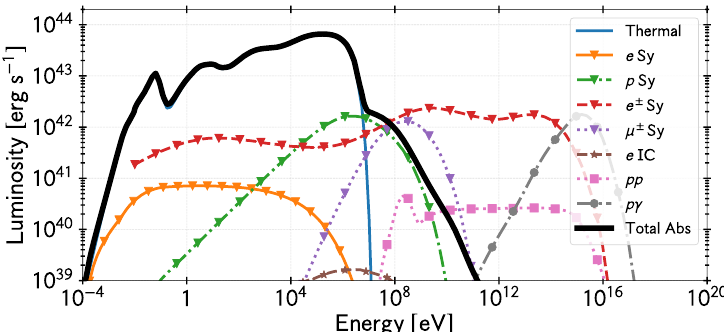
Figure 2. Complete spectral energy distribution produced by both thermal and non-thermal particles in the hot accretion flow for our fiducial model (see Table 1). The line style, marker, and color of the different emission processes are detailed in the legend. Thermal: Total emission from thermal electrons (see also Figure 1). e Sy: Synchrotron emission by primary nonthermal electrons. p Sy: Synchrotron emission by nonthermal protons. e ± Sy: Synchrotron emission by secondary electrons and positrons. µ ± Sy: Muon synchrotron emission. e IC: inverse Compton emission by primary nonthermal electrons. pp: Neutral pion decay via inelastic proton-proton collisions. p γ : Neutral pion decay via inelastic photohadronic collisions. Total Abs: Total electromagnetic radiative output taking into account internal